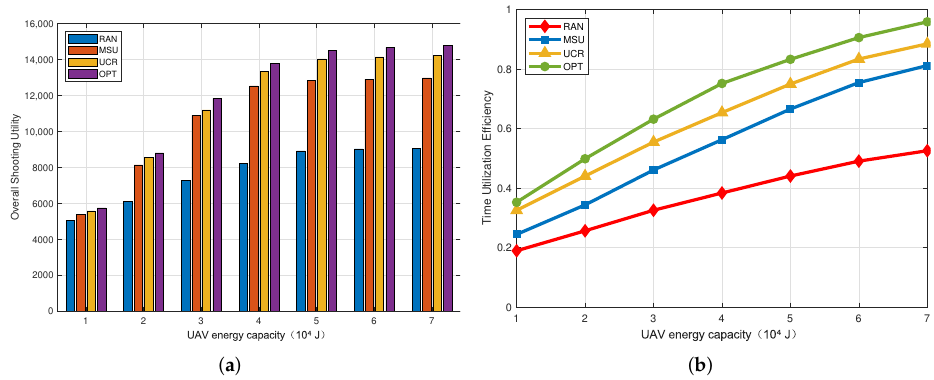
Figure 5. Impact of the UAV energy capacity. ( a ) Overall shooting utility; ( b ) Time utilization